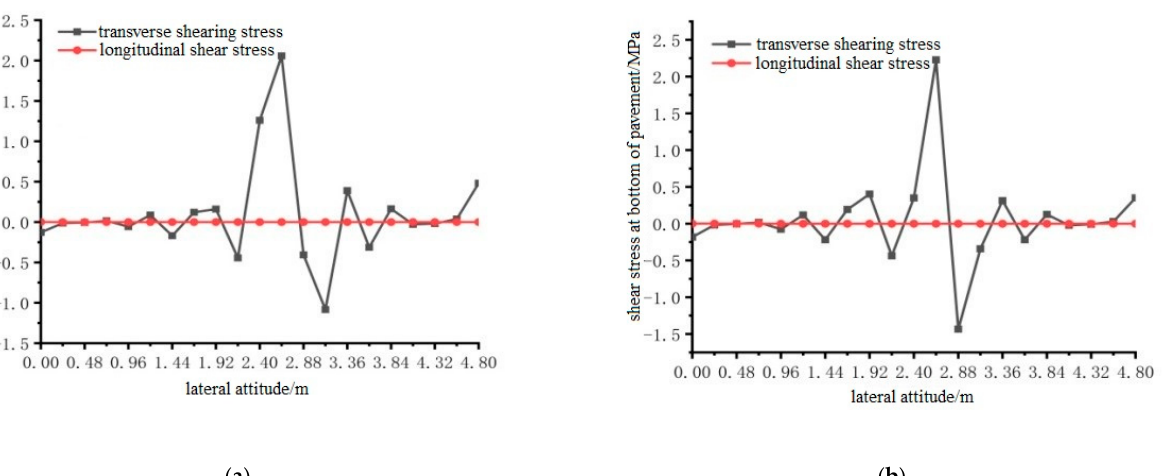
Figure 31. The transverse distribution of longitudinal and transverse shear stress of the bottom surface of the pavement with and without temperature field under the action of load level 2. ( a ) Longitudinal and transverse shear stress diagrams without temperature field; ( b ) Longitudinal and transverse shear stress diagrams with temperature field effect.